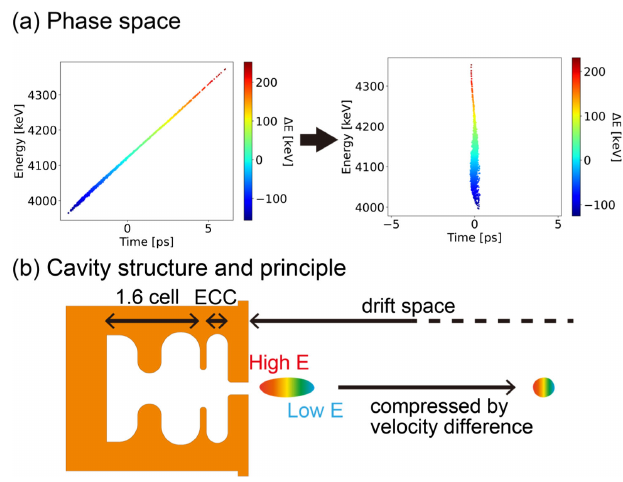
FIG. 1. (a) Phase space of the electron bunch generated by the ECC-rf gun simulated by GPT calculations. The colors show the energy difference. (b) Cavity structure and principle of operation of the ECC-rf gun.